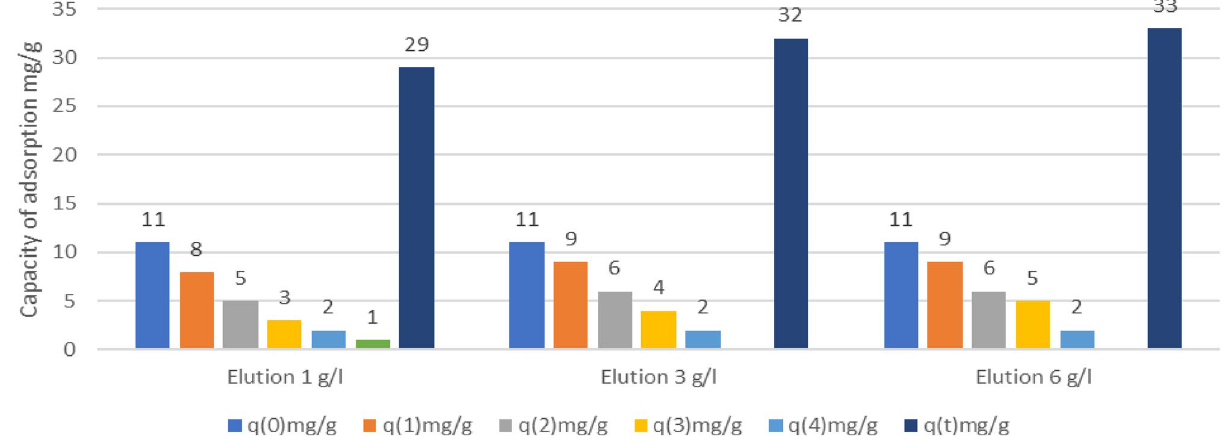
Figure 7. Adsorption capacities in the different adsorption processes in the biomass